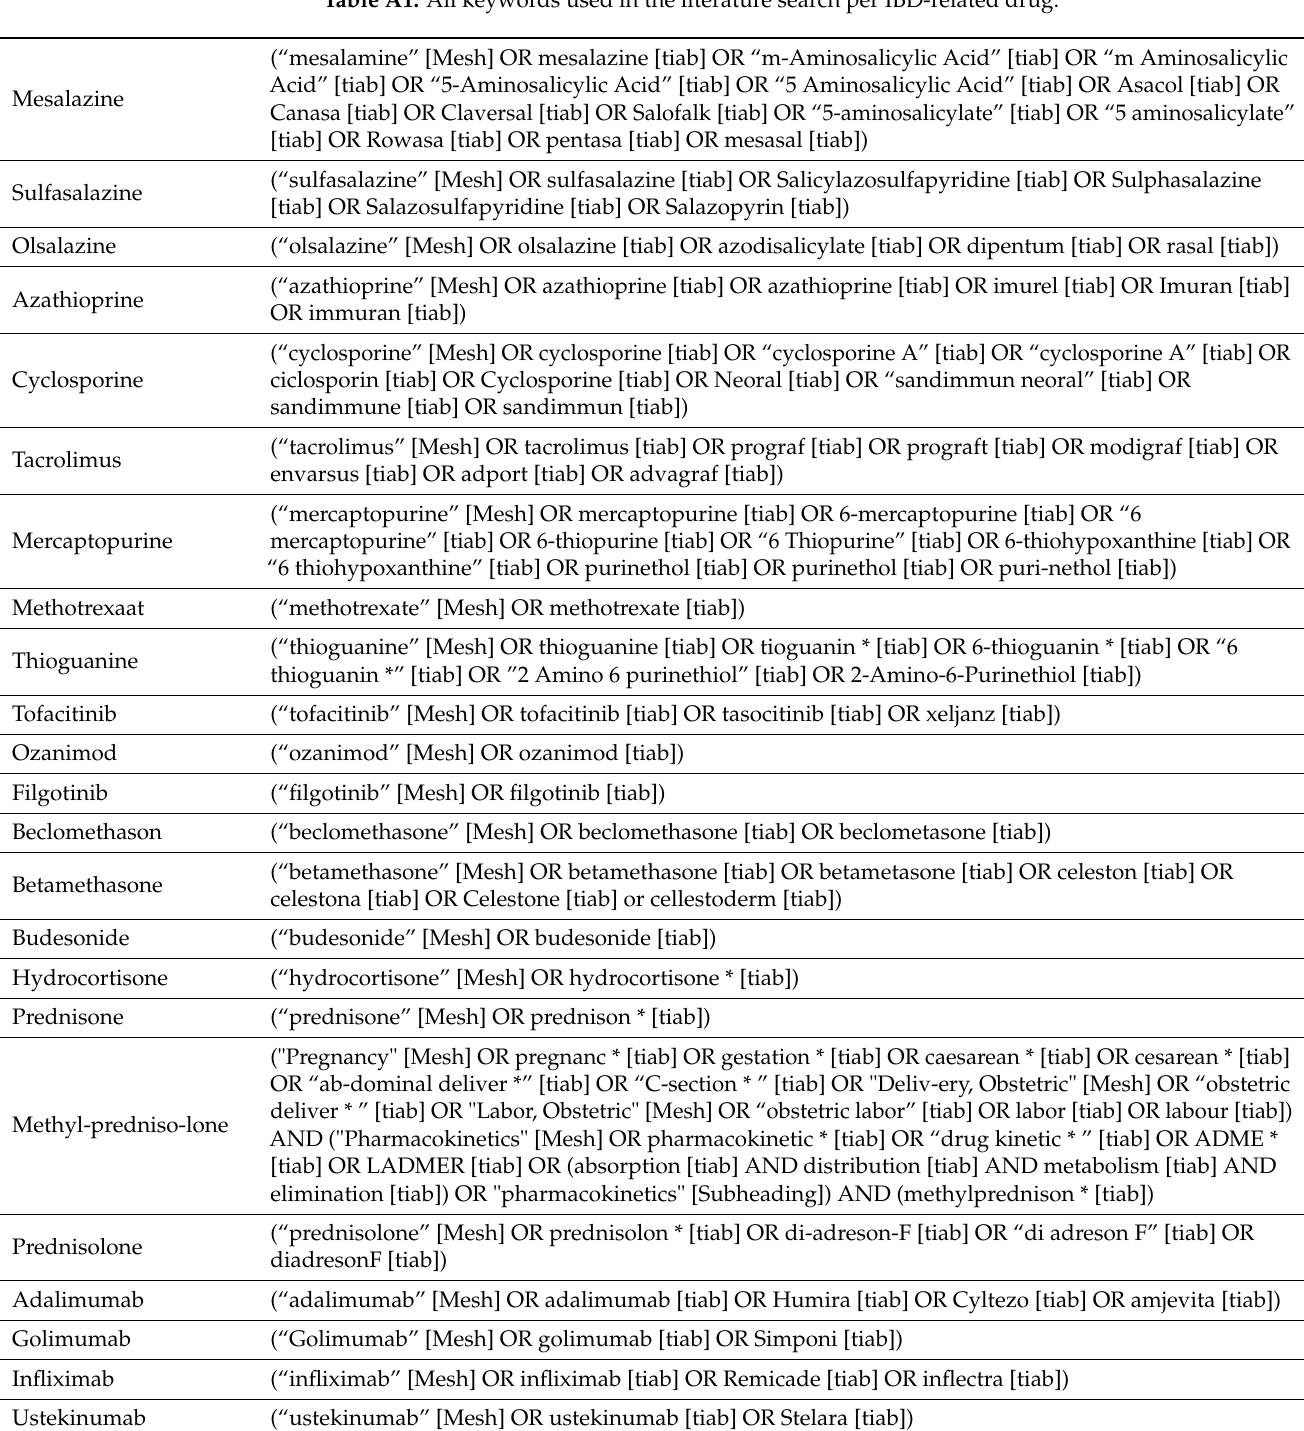
Table A1. All keywords used in the literature search per IBD-related